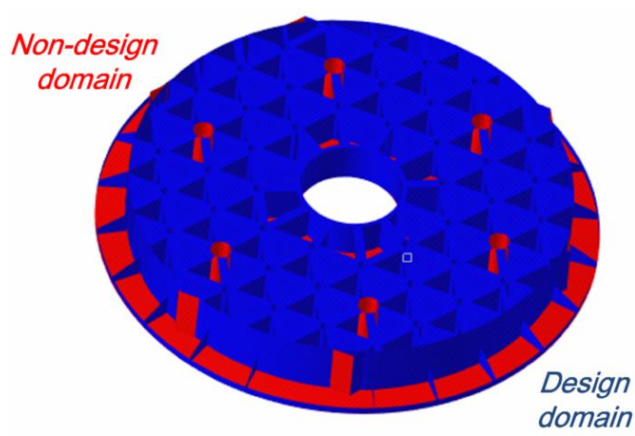
Figure 3. Design domain and non-design